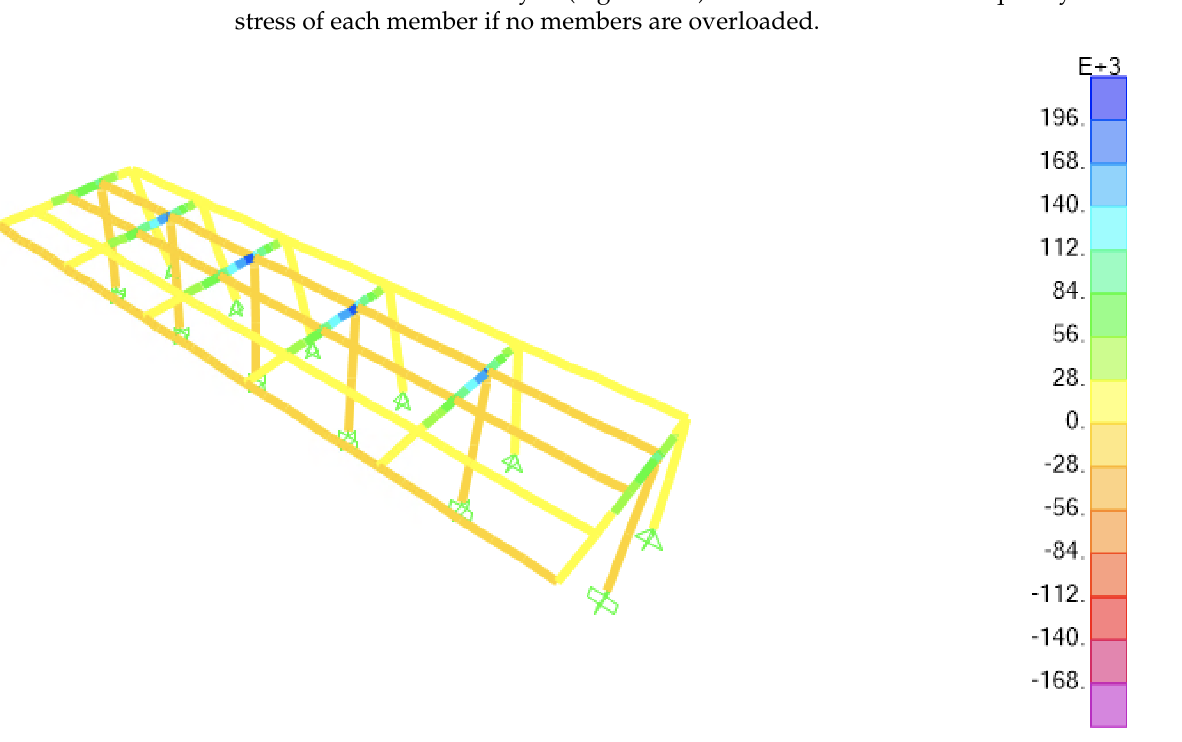
Table A5. Cantilevered system beam load table for a design load of 2.27 kPa.